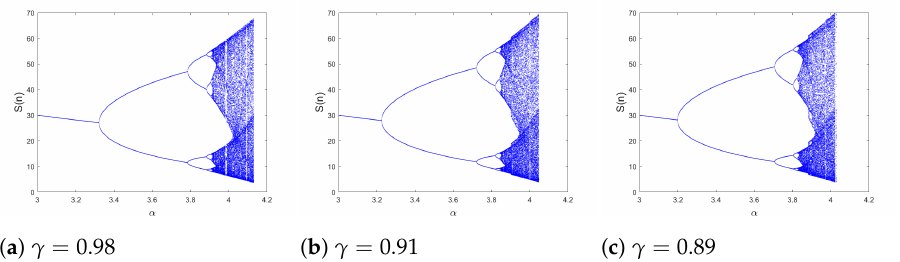
Figure 6. Bifurcation diagrams of the fractional discrete SIR model (11) for different commensurate fractional-order